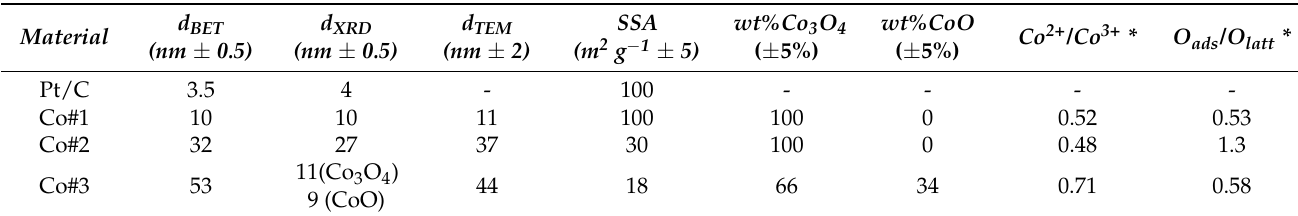
Table 1. Structural characterization data for the FSP-made Co - oxide